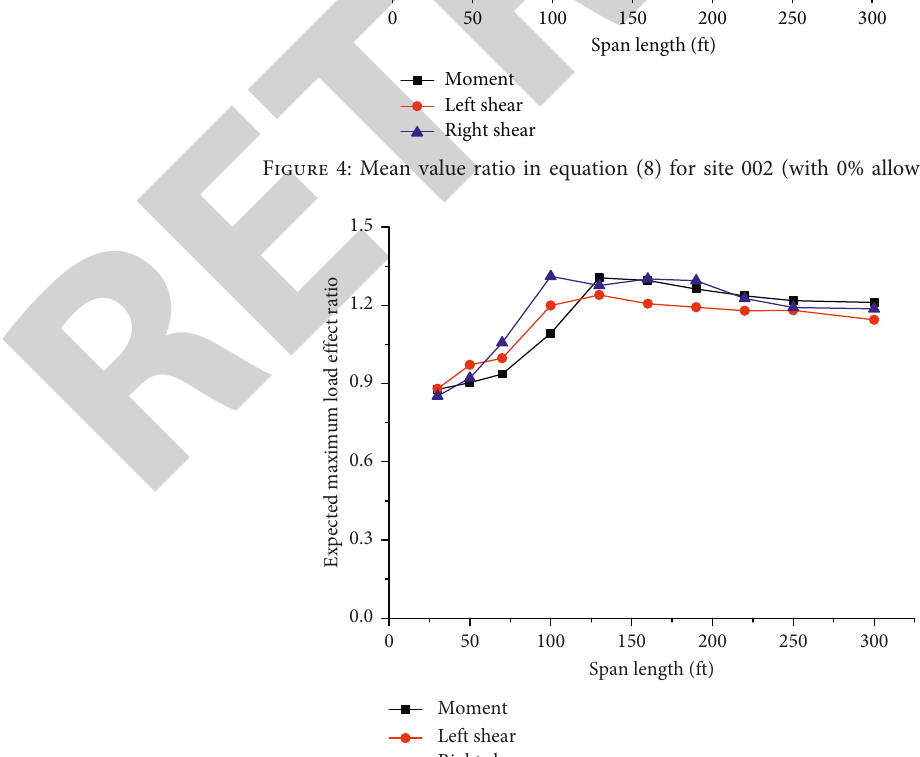
Figure 3: The flowchart of the calibration process.